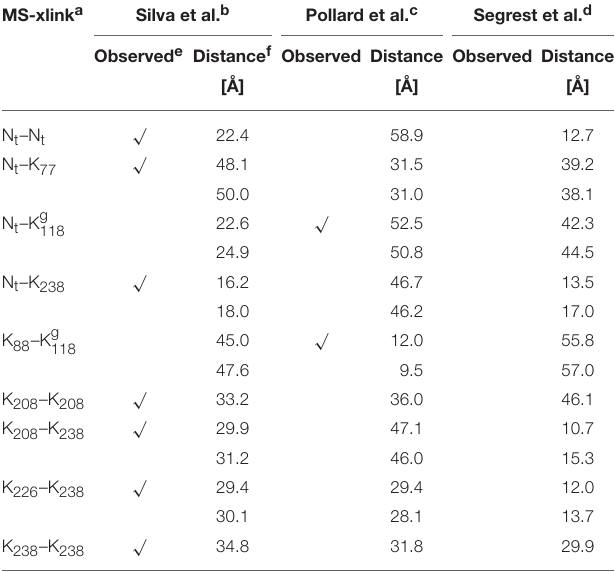
TABLE 1 | MS-crosslinks identified in the lipid free apoA-I dimer, and Lys-Lys distances, corresponding to these MS-crosslinks, measured in the model of lipid free apoA-I